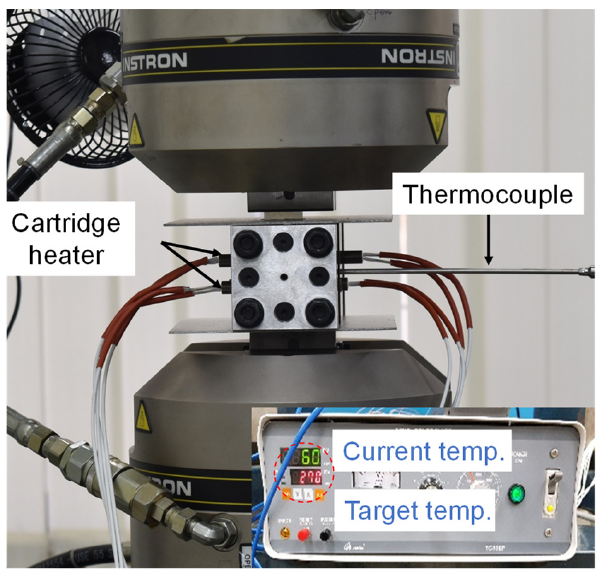
Figure 3. Experimental setup for tensile, creep, and stress relaxation